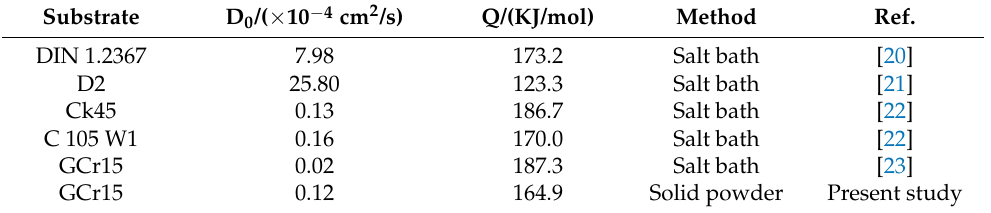
Table 2. D 0 and Q of vanadiumizing layer under different substrate